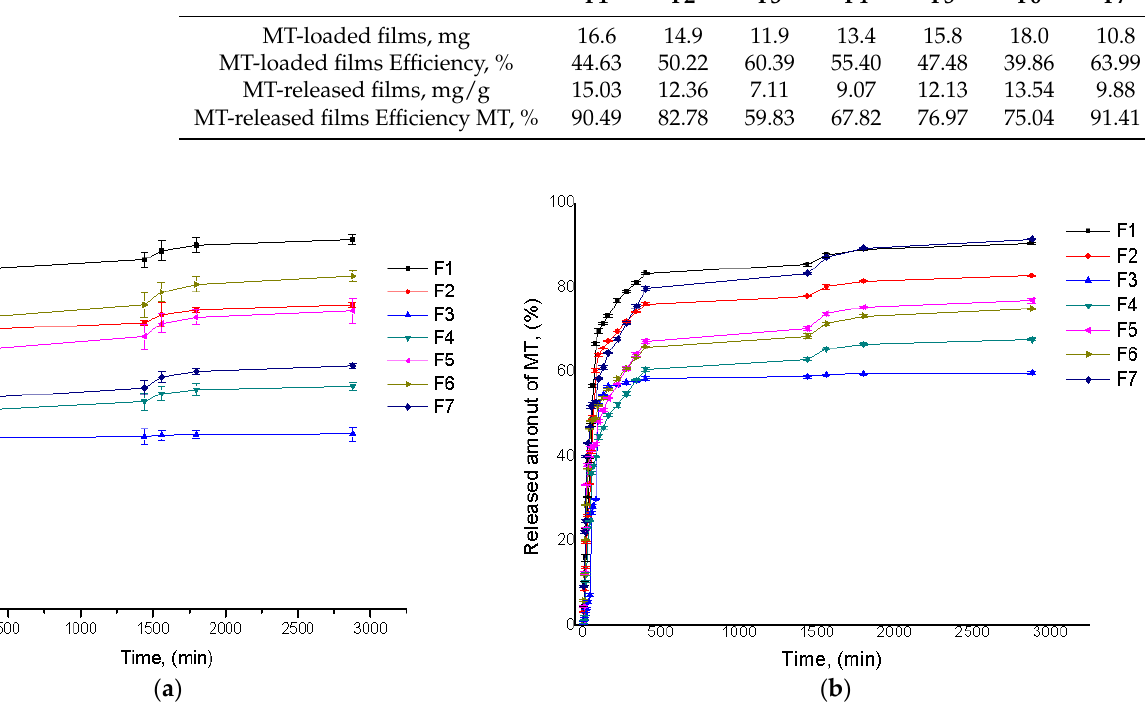
Figure 4. The MT release kinetics from synthesized films expressed in terms of mg/g ( a ) and released efficiency ( b ).